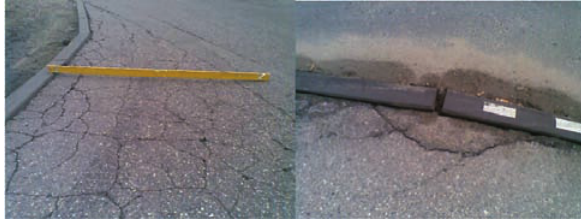
Fig. 10. Road structures damaged due to their unconformity to traffic and operational conditions